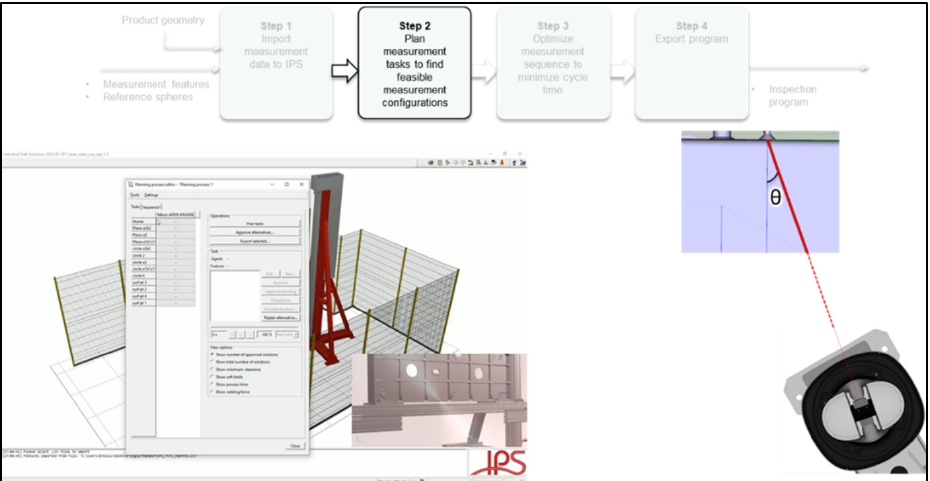
Figure 32. The evolved IPS LR system concept, Step 1.